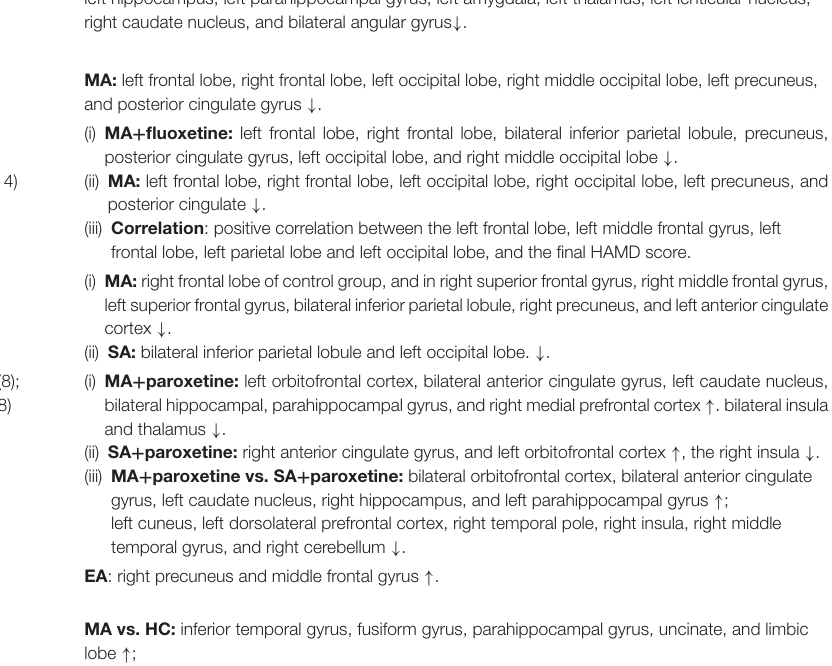
4 EA (40); 2 (i) MA + fluoxetine: left frontal lobe, right frontal lobe, bilateral inferior parietal lobule, precuneus,